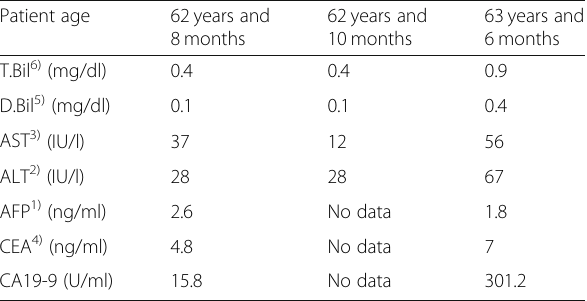
Table 1 Laboratory study results